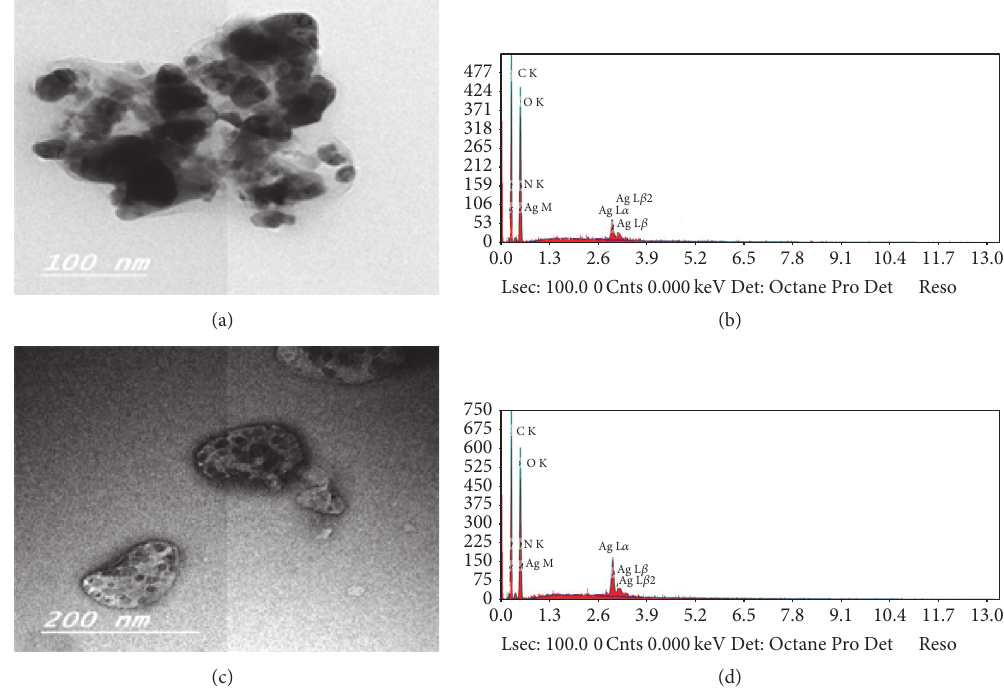
Figure 4: TEM of (a) CMCS/3-methyl-1H-pyrazole-4-carbaldehyde loaded with AgNPs. (b) EDX of CMCS/3-methyl-1H-pyrazole-4- carbaldehyde loaded with AgNPs. (c) TEM of CMCS/1,3-diphenyl-1H-pyrazole-4-carbaldehyde loaded with AgNPs. (d) EDX of CMCS/1,3-